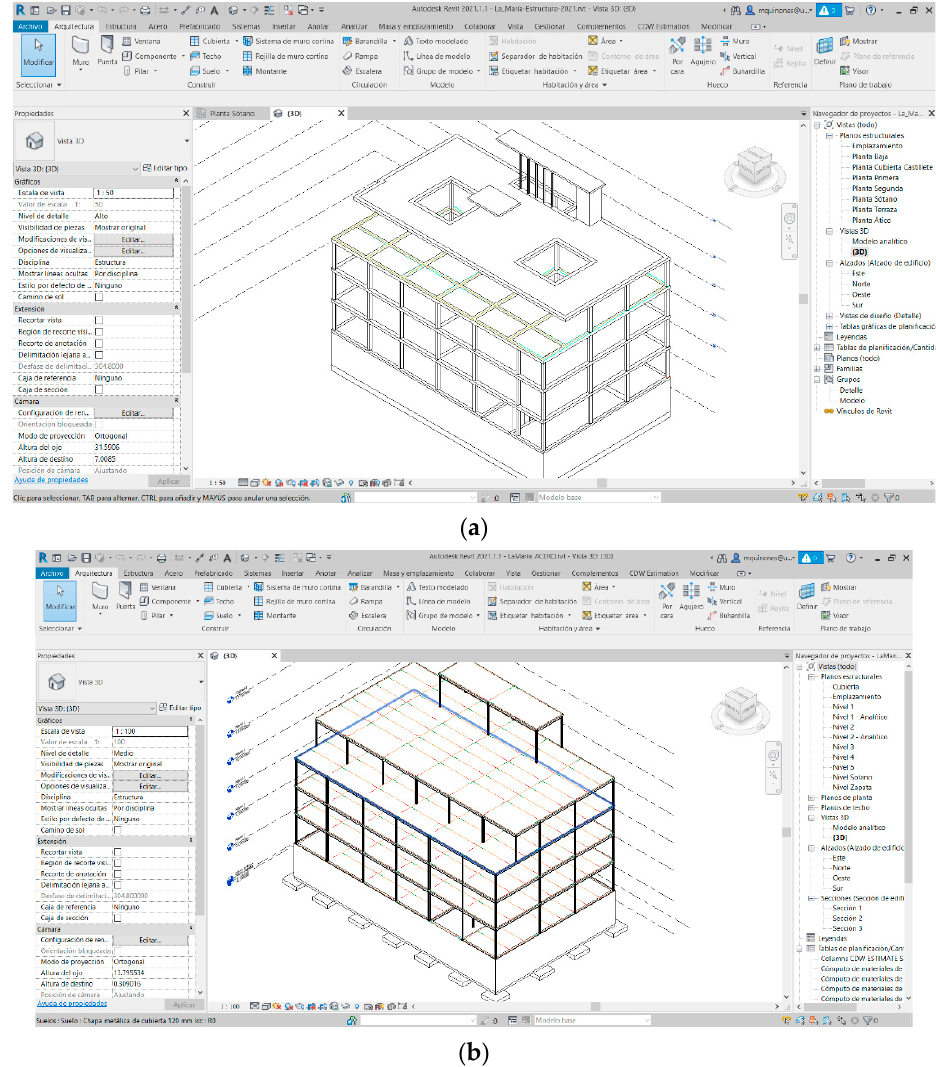
Figure 5. ( a ) BIM case study: Option 1, a reinforced concrete structure; ( b ) BIM case study: Option 2, a steel structure.